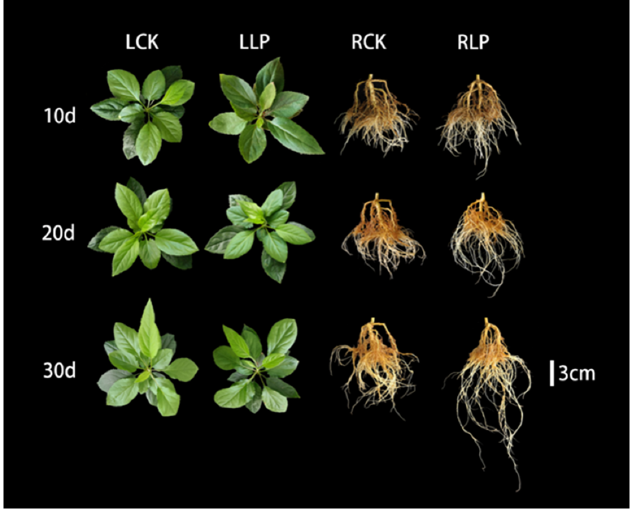
Figure 1. Morphological changes of leaves and roots when exposed to low − Pi treatment for different durations. (LCK: control leaves; RCK: control roots; LLP: Leaves under low − phosphorus treatment; RLP: Roots under low − phosphorus treatment).